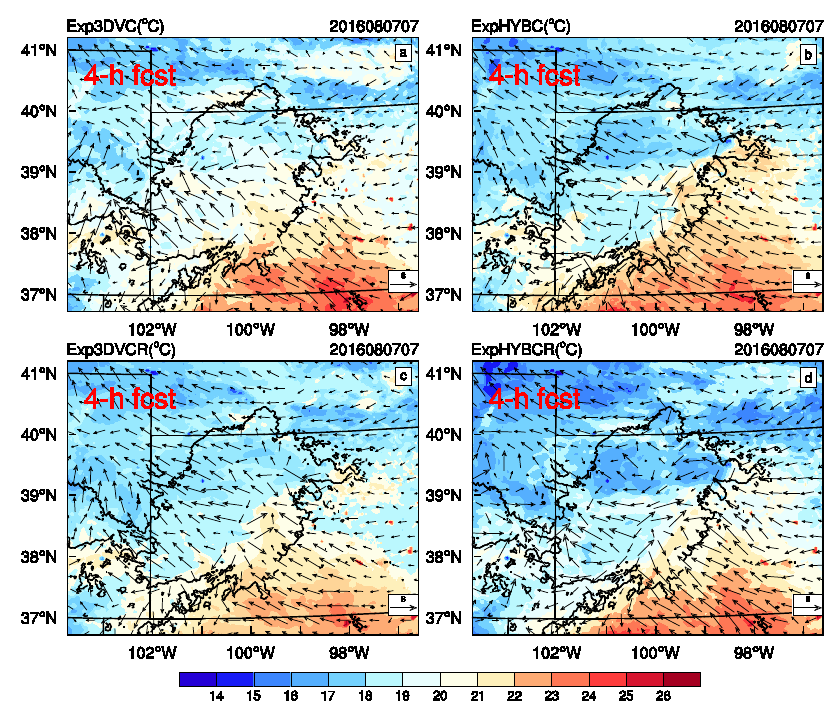
Figure 16. Surface temperature (unit: °C) and wind (unit: m s − 1 ) of: Exp3DVC ( a ); ExpHYBC ( b ); Exp3DVCR ( c ); and ExpHYBCR ( d ) of the convective system at 07:00 UTC on 7 August 2016 (initialized at 03:00 UTC on 7 August 2016). Solid black lines represent contours of observed reflectivity exceeding 20 dB Z . Atmosphere 2017 , 9 , x FOR PEER REVIEW